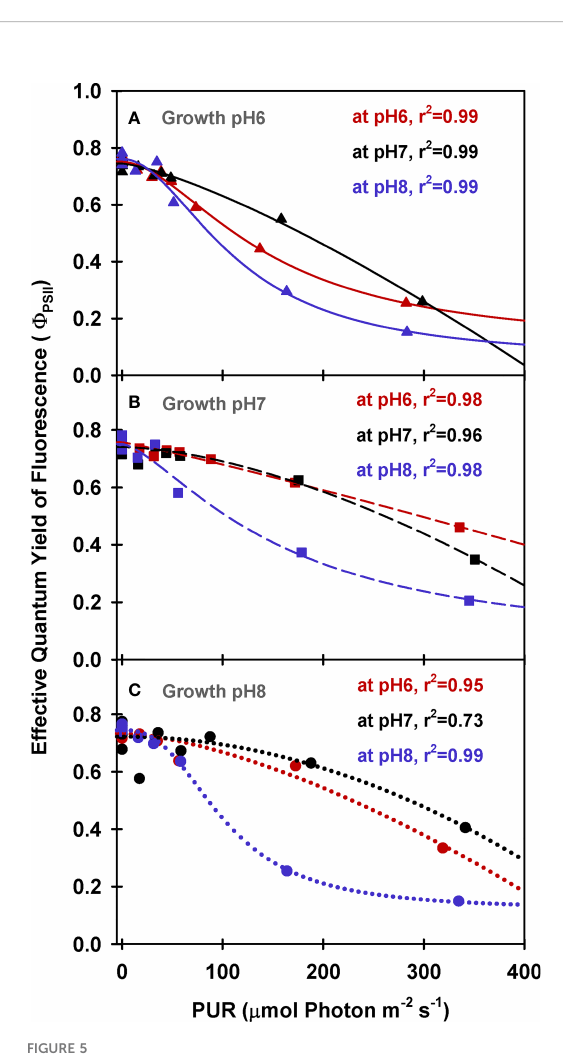
FIGURE 6 PAM fl uorescence parameters of eelgrass leaves as a function of absorbed irradiance. PAM fl uorescence measurements were performed at different pH/CO 2 levels (red: pH6, black: pH7, blue: pH8) using leaves grown at pH6 (2121 µ M CO 2(aq) ) (A) , pH7 (371 µ M CO µ M CO 2(aq) ) (B) and ambient pH8 (55 2(aq) ) (C) . Curves were fi t using Equation